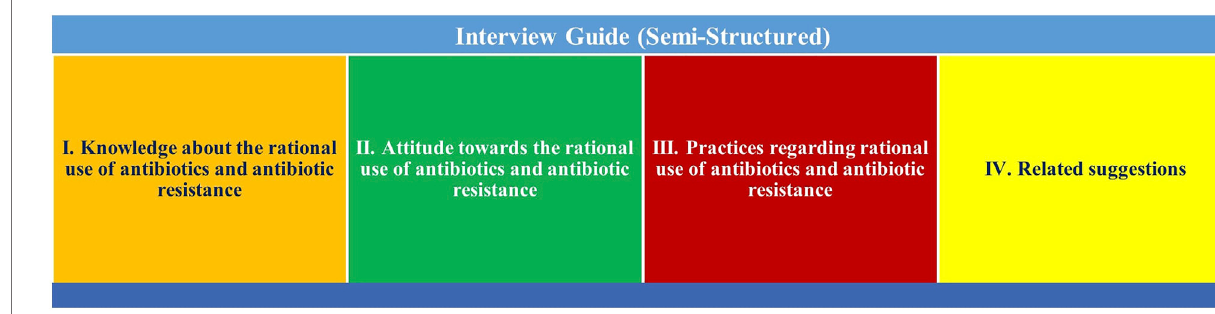
FIGURE 1 | In-depth semi-structured interview guide summary of the themes.